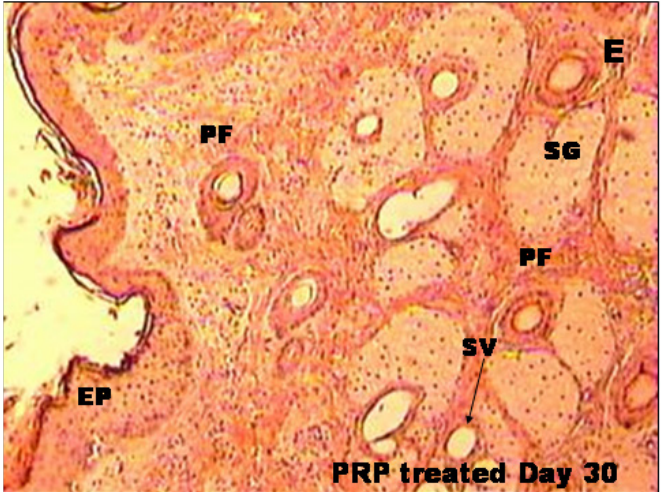
FIGURE 7 - PRP group at Day 30 showing the epidermis (EP). The dermis shows connective tissue (CT) with sebaceous glands (SG) and pilous follicles (PF) and small vessels (SV). 5X increase. HE coloration